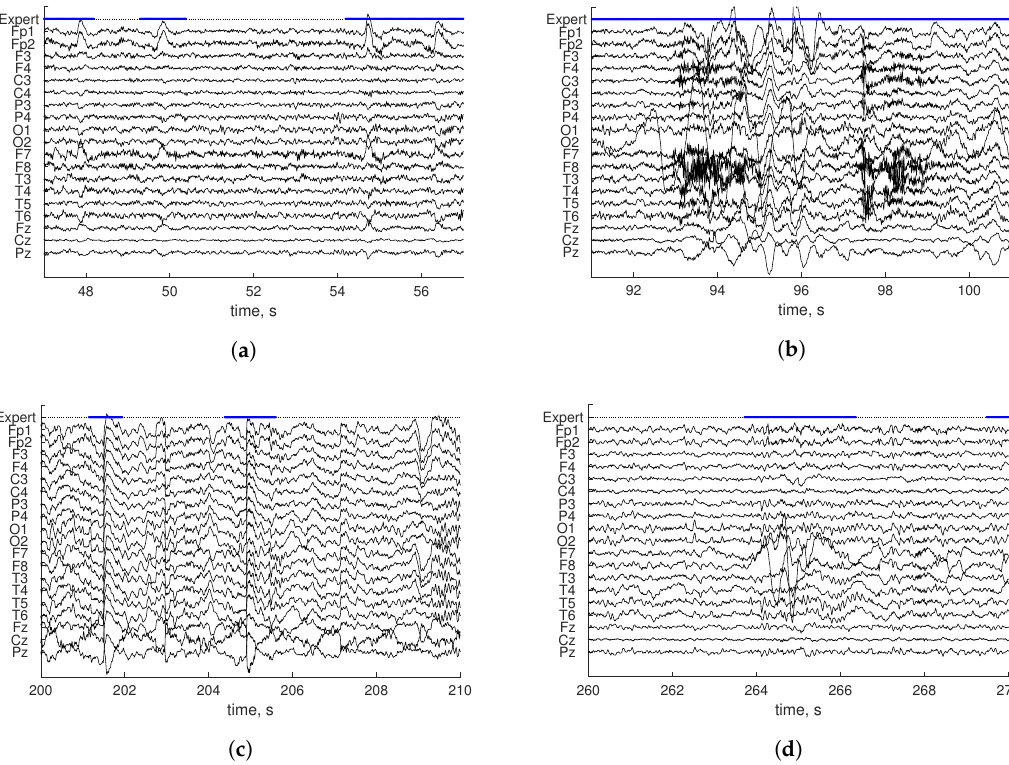
Figure 1. Expert labeling (Expert) of blinking artifacts ( a ), movement artifact during wakefulness ( b ), and electrode artifacts in non-REM 3 ( c ) and REM ( d ). Solid blue lines are the expert’s artifact